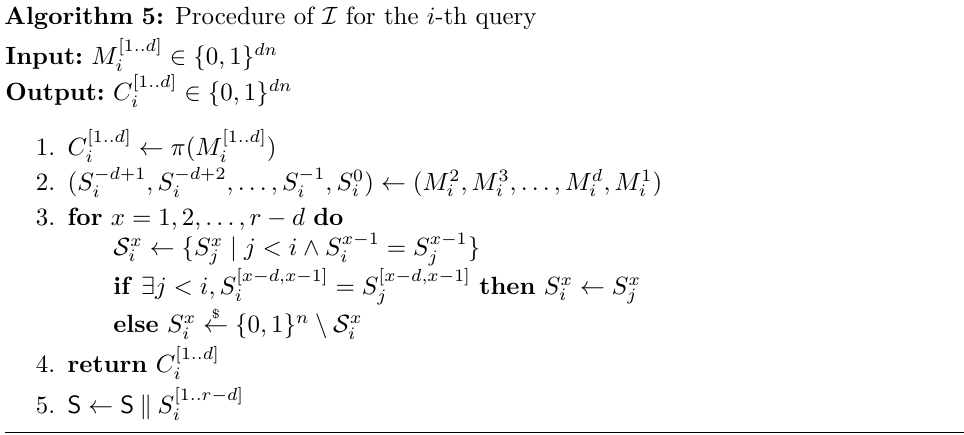
Algorithm 6: Procedure of I − 1 for the i -th query